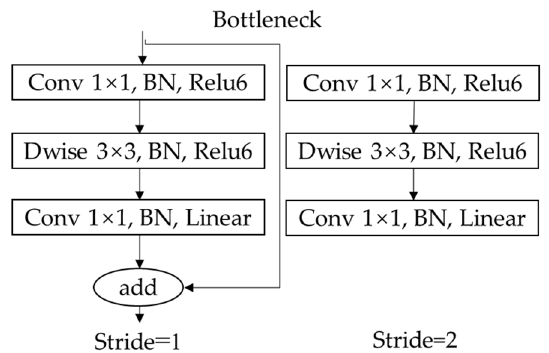
Figure 4. The structure of the Bottleneck module.